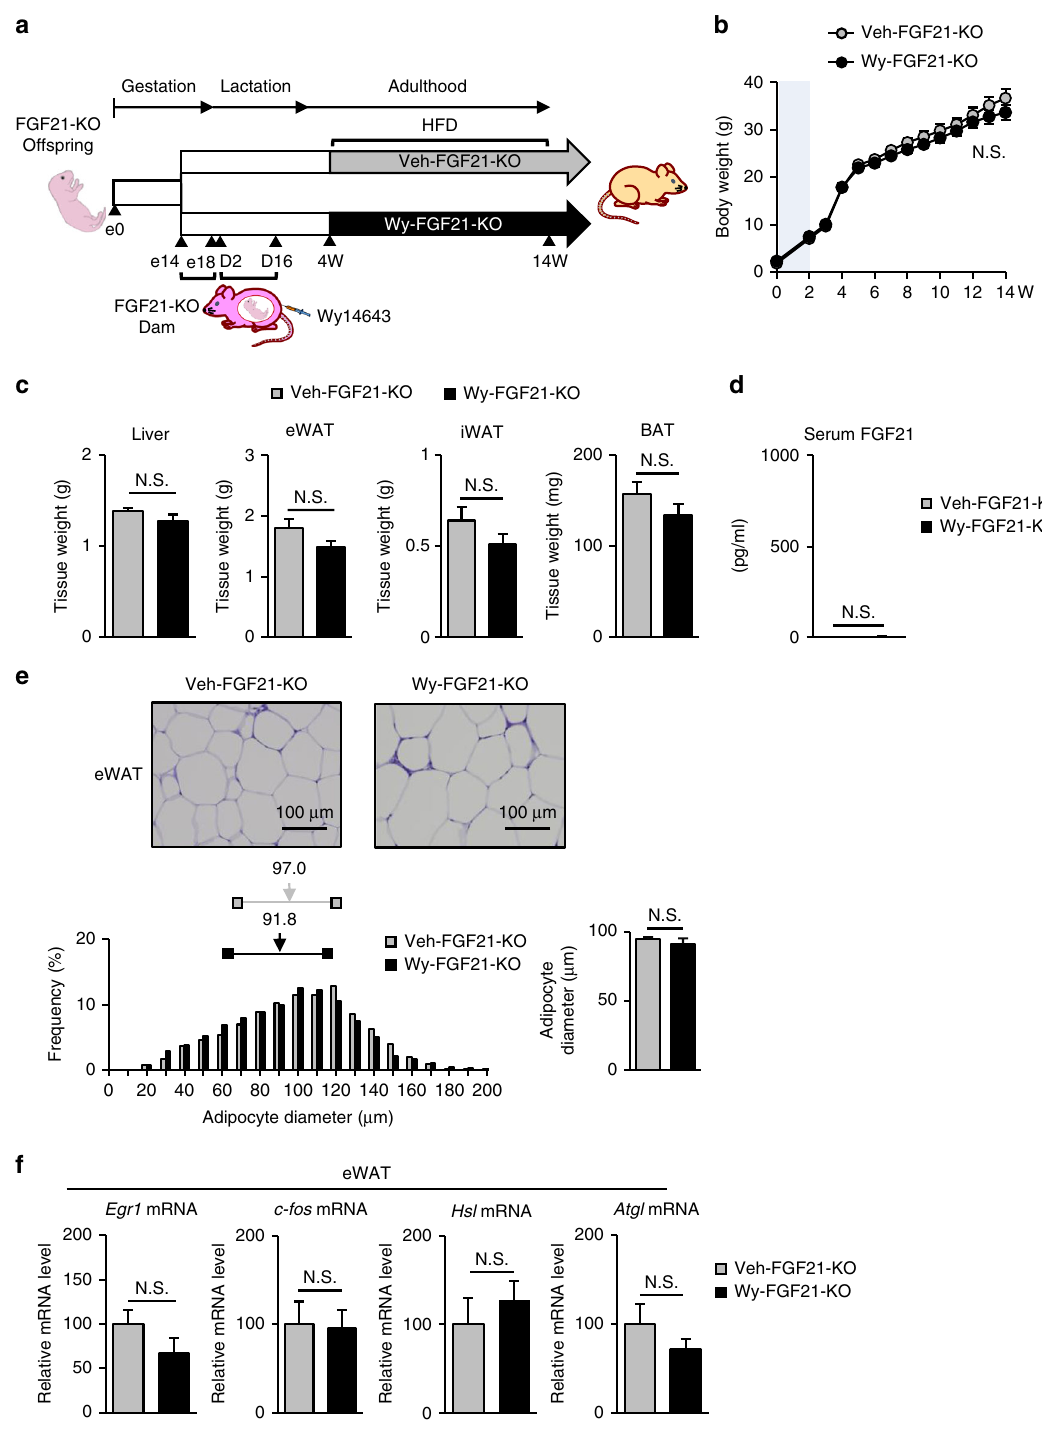
Fig. 8 Analysis of FGF21-de fi cient (KO) mice. a Experimental protocol of maternal administration of Wy or DMSO (Veh) to FGF21-KO dams during the late gestation (e14 – e18) and lactation periods (D2 – D16). Offspring derived from Wy- or Veh-administered dams are referred to as Wy-FGF21-KO and Veh- FGF21-KO, respectively. These offspring were treated with HFD diet for 10 weeks in adulthood (from 4W to 14W). b Body weight changes during HFD feeding ( n = 7 – 9 per group, statistics by two-way ANOVA with repeated measures). c Tissue weight of Wy- and Veh-FGF21-KO at 14W. d Serum FGF21 levels of Wy- and Veh-FGF21-KO at 14W. e Hematoxylin and eosin (HE) staining (top, representative image of 7 – 9 individuals per group) and quanti fi cation of adipocyte diameter (bottom) of eWAT. Histograms of adipocyte diameter (bottom left). Horizontal lines with bilateral squares indicate interquartile range (IQR). Arrows indicate the median values (numbers above the horizontal lines) of Veh-FGF21-KO and Wy-FGF21-KO. Statistical analysis (bottom right) of mean adipocyte diameters ± SEM are shown. Scale bar = 100 µ m. f Relative mRNA expression of Egr1 , c-fos , Hsl , and Atgl in eWAT, n = 7 – 9 per group. Statistics by unpaired Student ’ s t -test otherwise indicated. Data are expressed as mean ± SEM. N.S., not signi fi cant vs.